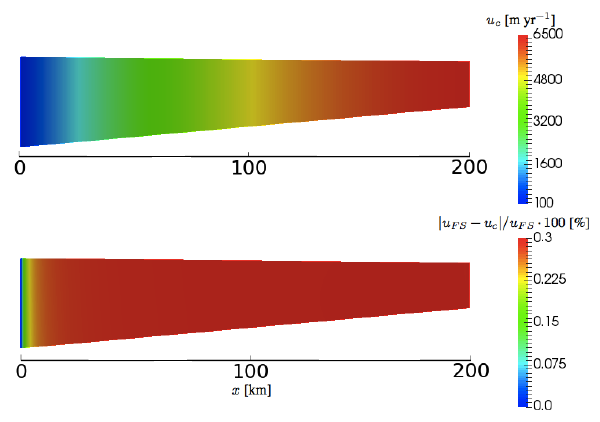
Figure 2. The horizontal velocity u c (myr − 1 ) and node-wise dif- ference | u FS − u c | /u FS · 100 (%) in the coupled solution for the 2-D ice shelf ramp. The vertical scale is exaggerated 100 times. The ice thickness ranges from 400 to 200m.